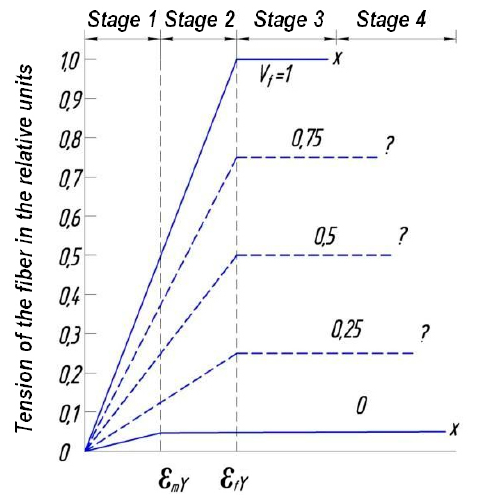
Fig. 1. Stress-strain diagram of a “model” composition (dashed lines) consisting of plastic filaments and a plastic matrix (solid lines): V f – volumetric fraction of fibers, ε m and ε f – the proportional limit of the matrix and fibers (McDanels et al .